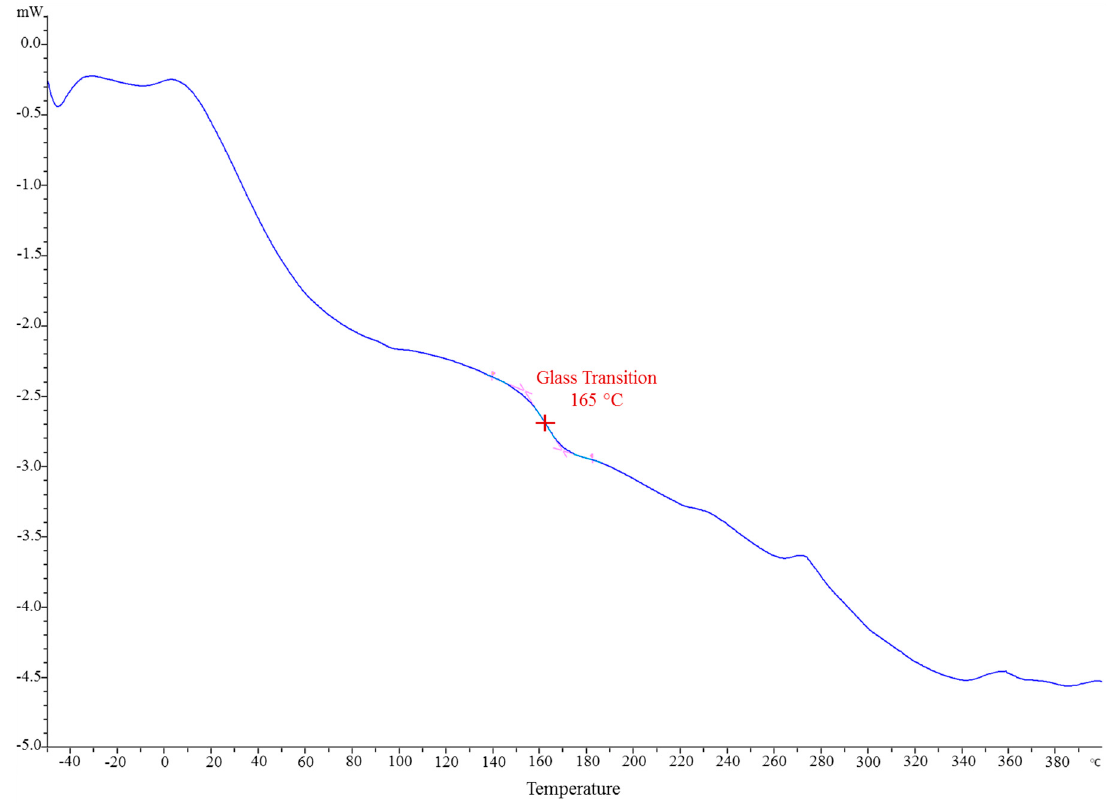
Figure 10. DSC analysis of PEEKN7.